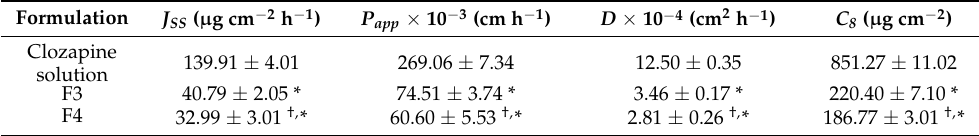
Table 8. Ex vivo permeation characteristics of clozapine across sheep nasal mucosal tissues ( n = 3 ± SD).